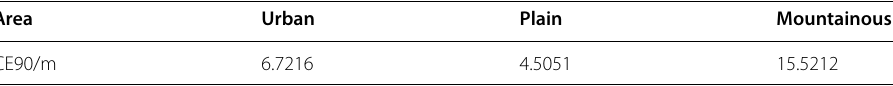
Table 2 Accuracy evaluation based on circular probability